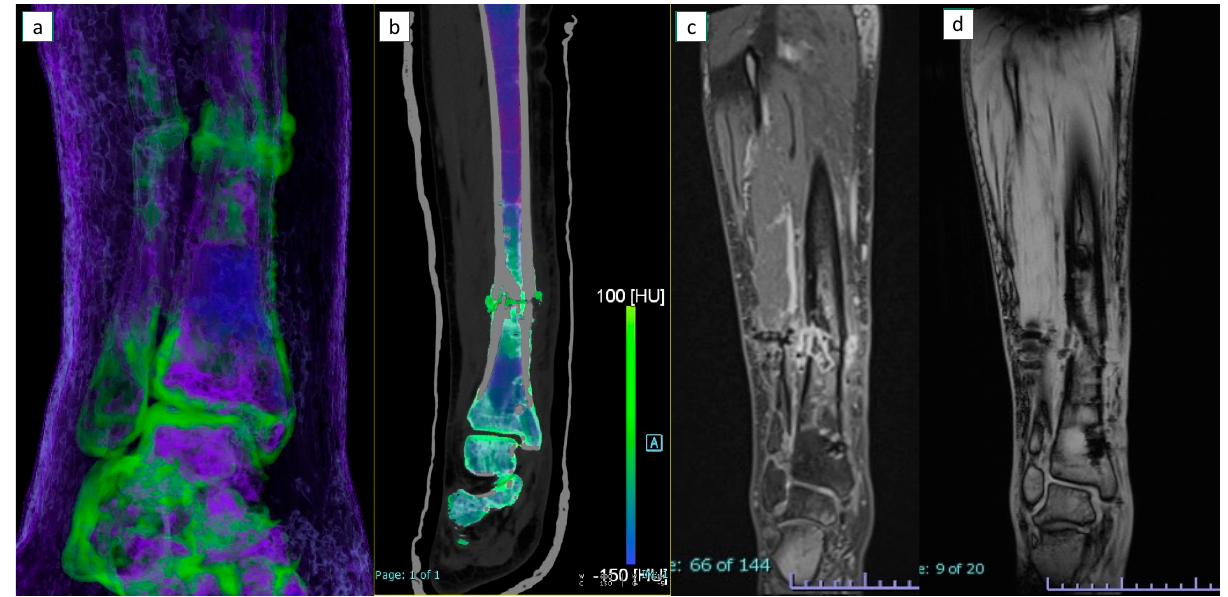
Figure 4. A 52-year-old female with osteomyelitis on tibial exposed fracture. On coronal 3D ( a ) and 2D ( b ) dual-energy CT images, severe bone marrow edema is identified around the fracture line. Additional edema is also present on the adjacent soft tissues. On the corresponding coronal MRI T1-weighted image after contrast material administration ( c ), additional edema with a sequestrum is depicted around the fracture foci. The corresponding T1-weighted image without contrast material ( d ) was considered non-diagnostic because of some metal-induced artifacts from a previous surgical fixation.